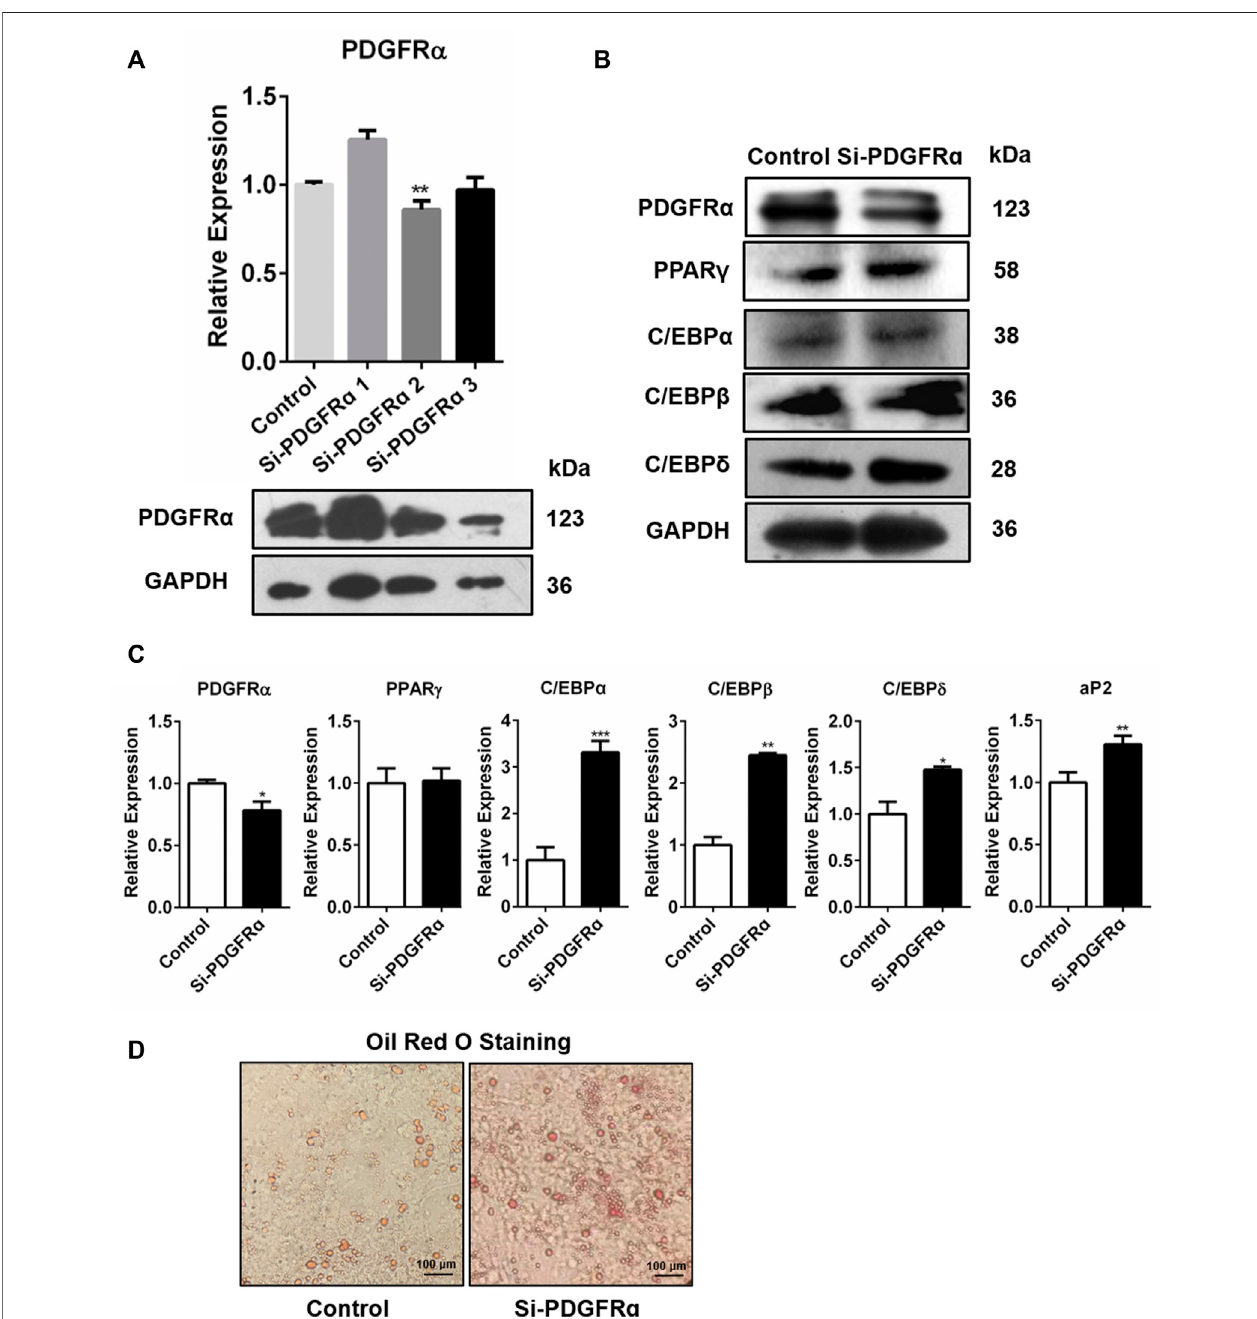
FIGURE 5| Increasein adipocyte differentiation-related gene expression and enhancement in lipid droplet synthesis by PDGFR α knockdown. (A) qRT-PCR along with Western blot assays of PDGFR α expression after transfection of 3T3-L1 cells with PDGFR α siRNA 1(Si-PDGFR α 1), PDGFR α siRNA 2(Si-PDGFR α 2), and PDGFR α siRNA 3(Si-PDGFR α 3), respectively. (B) Western blot assessment of the expression of adipocyte differentiation-related transcription factors after being transfected with PDGFR α siRNA (Si-PDGFR α ) or control in 3T3-L1 cells. (C) RT-PCR analysis of mRNA expression of adipocyte differentiation-related genes after transfection with PDGFR α siRNA(Si-PDGFR α )or controlin3T3-L1cells. (D) Illustrativeimages ofoilred Oafter transienttransfection withPDGFR α siRNA(Si-PDGFR α )or controlin3T3- L1 cells (100-fold magni fi cation).